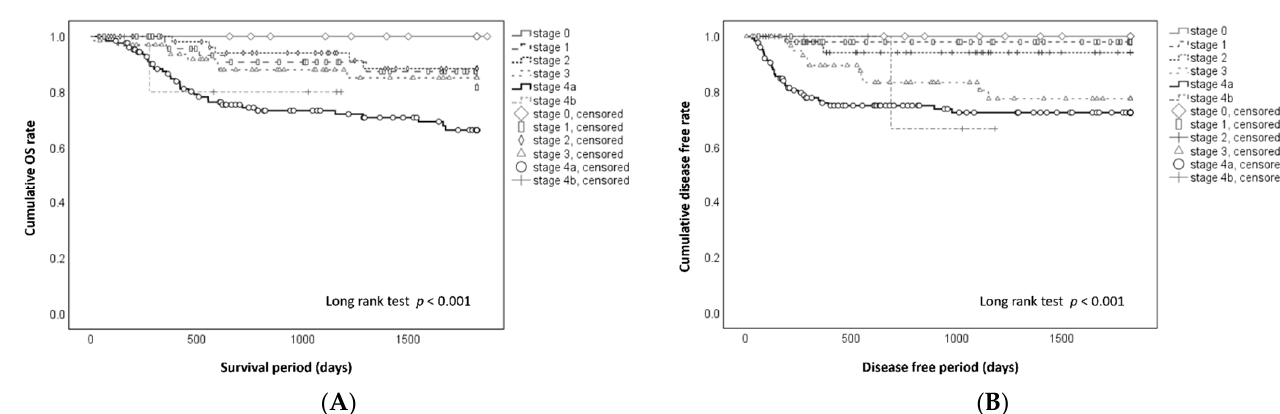
Figure 1. ( A ). Cumulative overall survival (OS) rate in patients with oral squamous cell carcinoma. The 5-year OS rates were 100% at stage 0, 81.5% at stage 1, 88.4% at stage 2, 85.0% at stage 3, 66.3% at stage 4A, and 80.0% at stage 4B ( p